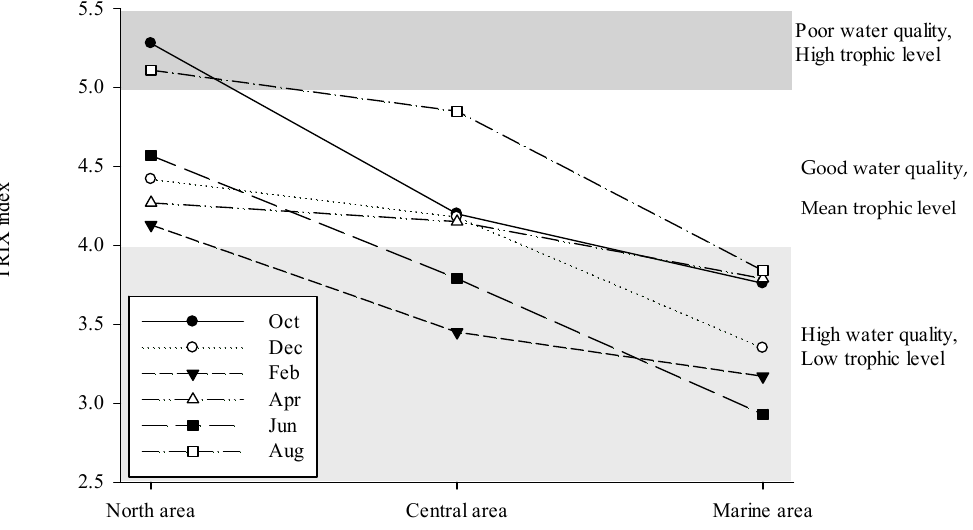
Figure 4. The Trophic index (TRIX) values in the three areas of the Juluapan Lagoon throughout the period sampled. Water quality and trophic levels are marked according to the value of the TRIX index based on the proposal of Penna et al. [37] (for statistical details, see Table A2).